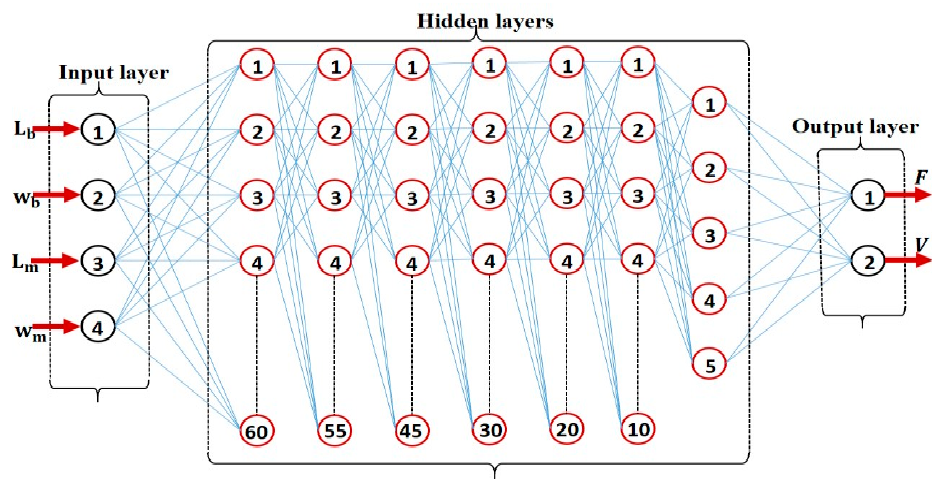
Figure 2. Illustration of the utilized deep neural network (DNN) for estimating the performance of the proposed low-resonant-frequency piezoelectric MEMS energy harvester.